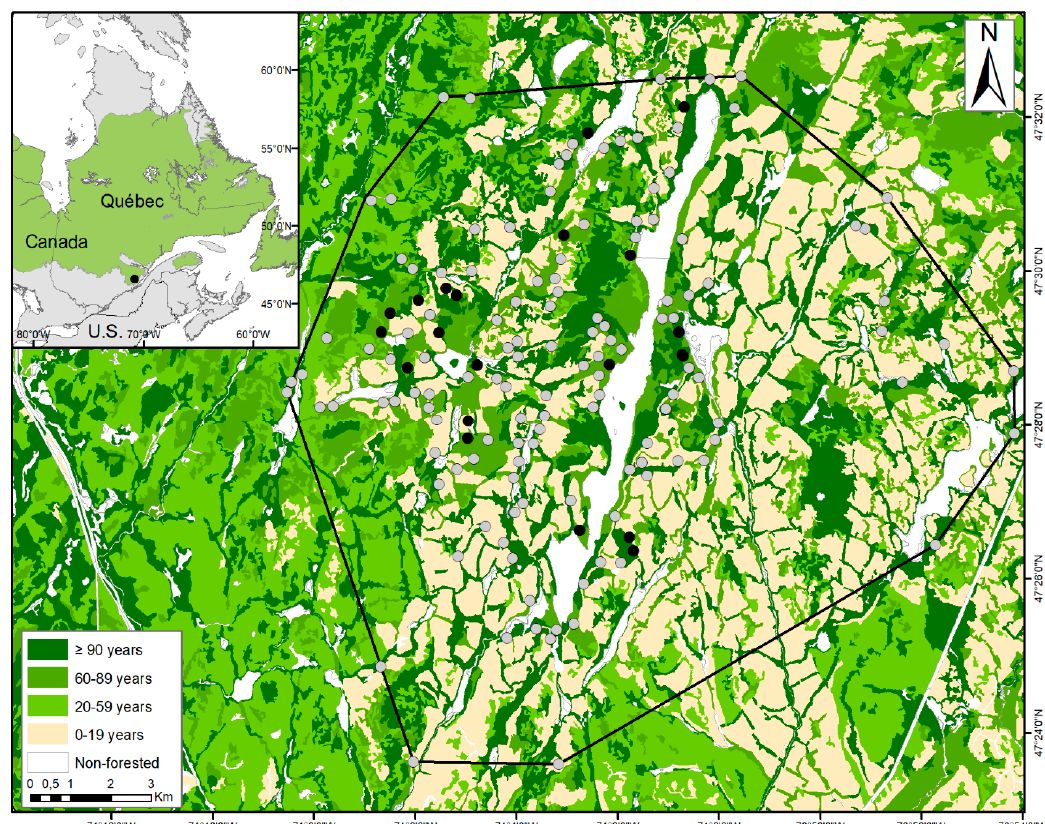
Figure 1. Habitat composition and location of surveyed stations where American Three-toedWoodpecker was detected (black circles) and not detected (grey circles) during occupancy surveys conducted between 2016 and 2017 within the Forêt Montmorency and the Réserve Faunique des Laurentides (Québec, Canada). Boundaries of the boreal zone [28] are delimited by the green zone in the left insert. The black line delineates the boundaries of the study area in the large insert.